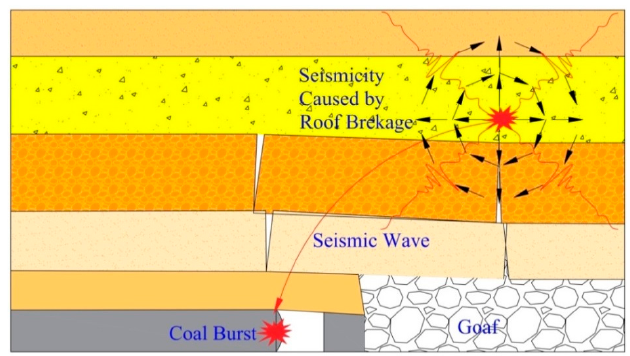
Figure 4. Influence of a dynamic load caused by seismicity on a coal burst [49].